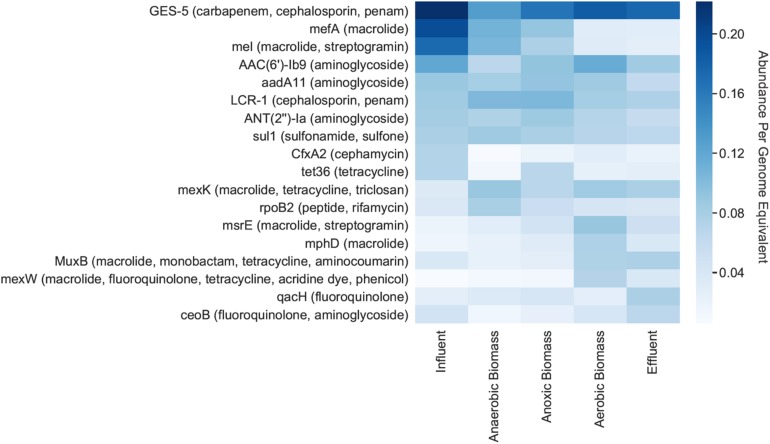
Relative abundances per genome equivalent of individual antibiotic resistance genes. The 10 most abundant ARGs for each cellular metagenome are shown, along with the antibiotic(s) that each gene putatively confers resistance to (in parentheses). “Cellular metagenomes” refers to metagenomes derived from samples collected for bacterial analyses.